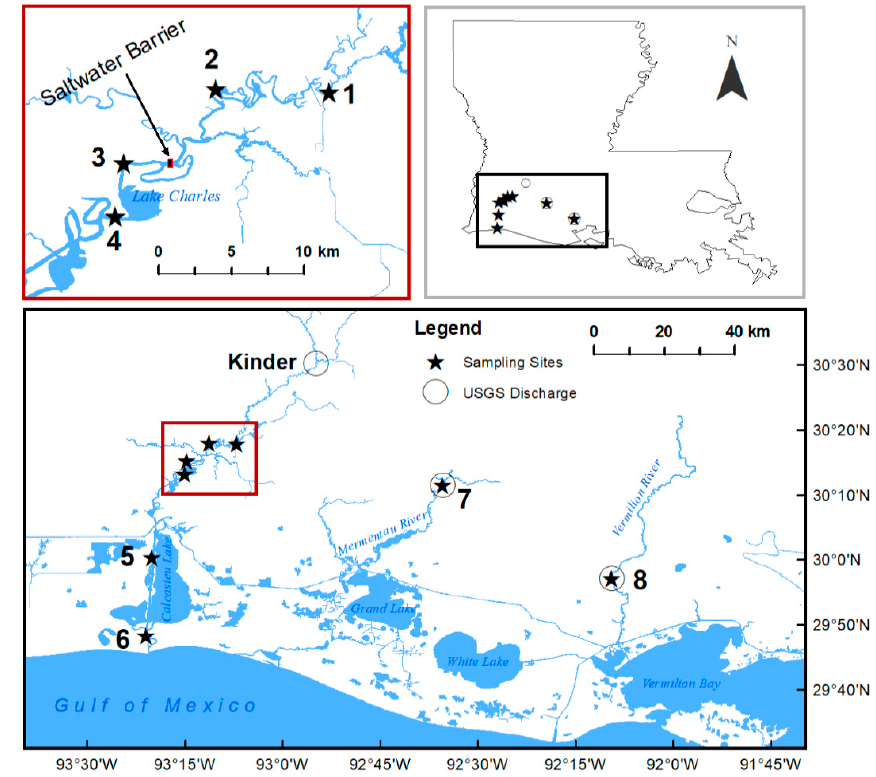
Figure 1. Geographic location of the Calcasieu, Mermentau, and Vermilion Rivers entering the Northern Gulf of Mexico, and the locations of eight sampling sites and United States Geological Survey (USGS) discharge gauging sites. The Vermilion and Mermentau River Basins are agriculture-intensive (i.e., 67% and 61% agricultural land use), while the Calcasieu River Basin is much less agriculture-intensive (i.e., 26%).